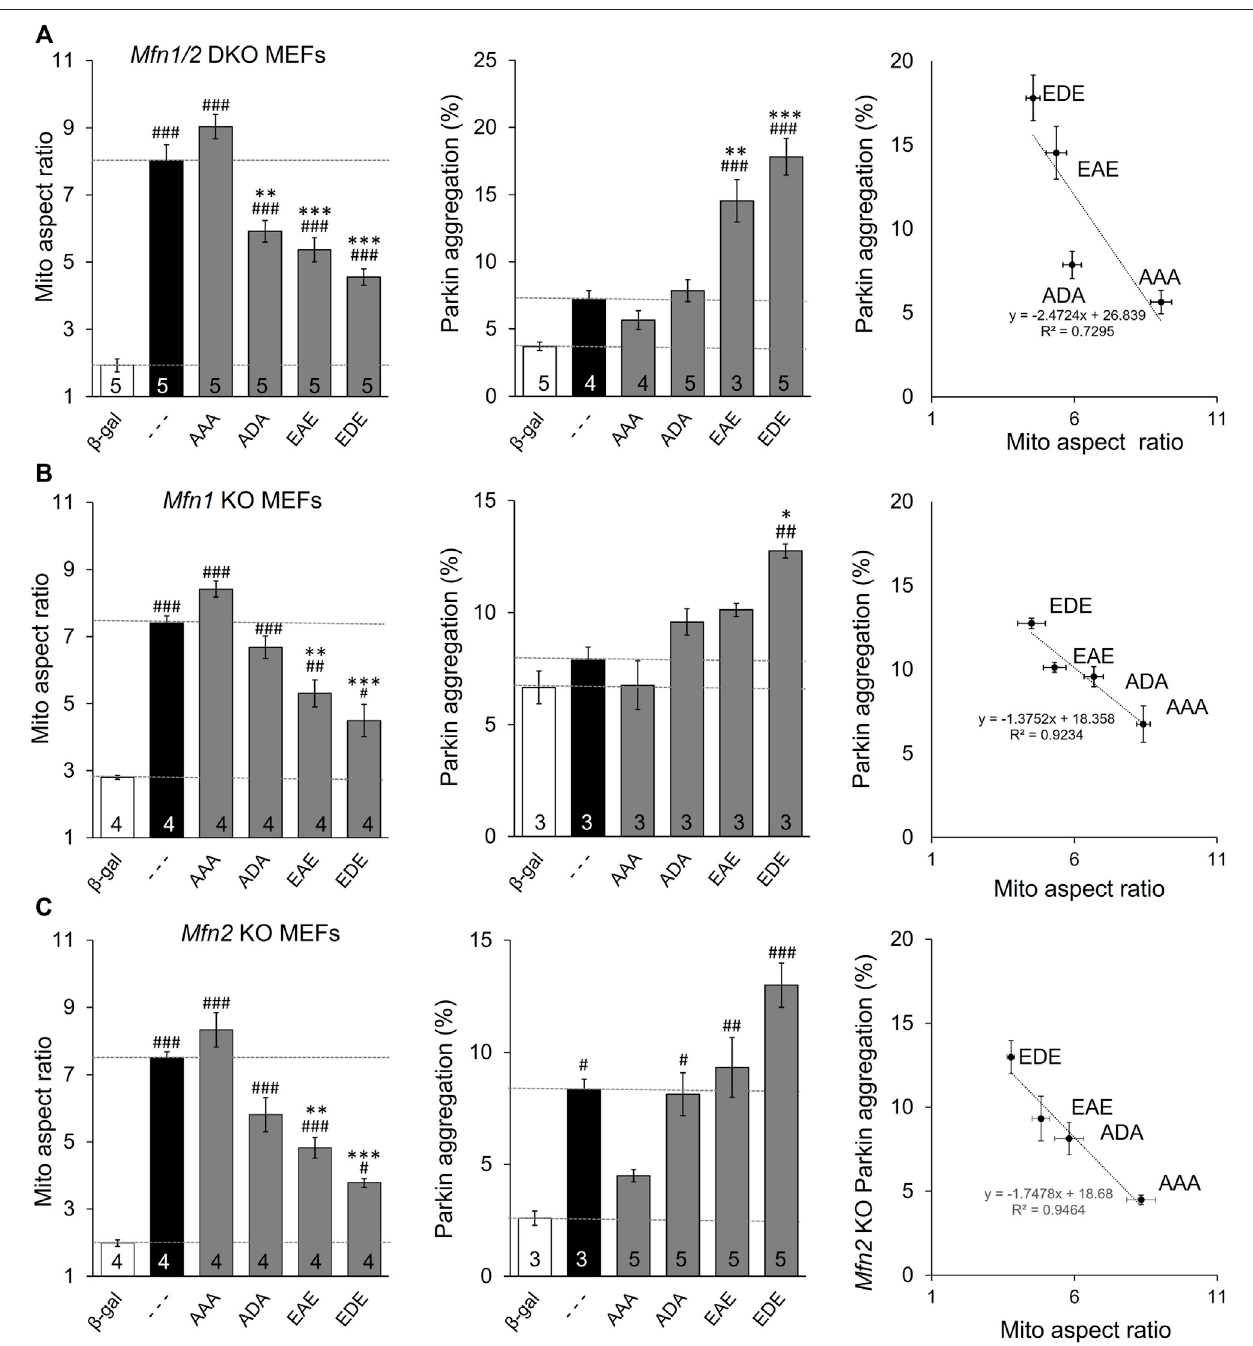
FIGURE 3 | MFN2 PINK1 phosphorylation site mutants dominantly affect mitochondrial fusion and mitophagy in Mfn1 , MFn2 , or Mfn1/Mfn2 null MEFs. MFN2 triple mutants designated as in Figure 1A were expressed by adenoviral transduction of Mfn1 , Mfn2 , or Mfn1/Mfn2 null murine fi broblasts. Adeno β -gal was negative control; --- indicates no mutation at T111, S378 or S442 (i.e. WT MFN2). (A) Mitochondrial aspect ratio (left panel), Parkin recruitment (middle panel) and 2-dimensional plot of mitochondrial aspect ratio vs. Parkin aggregation as a function of MFN2 phosphorylation site (right panel) in Mfn1/Mfn2 null MEFs. (B) Mitochondrial aspect ratio (left panel), Parkin recruitment (middle panel) and a 2-dimensional plot of mitochondrial aspect ratio vs. Parkin aggregation as a function of MFN2 phosphorylation site (right panel) in Mfn1 null MEFs. (C) Mitochondrial aspect ratio (left panel), Parkin recruitment (middle panel) and a 2-dimensional plot of mitochondrial aspect ratio vs. Parkin aggregation as a function of MFN2 phosphorylation site (right panel) in Mfn2 null MEFs. N shown is number of independent experiments. Mutant vs. adeno WT Mfn2: p < 0.05 *; p < 0.01 **; p < 0.001***; MFN2 vs. adeno β -gal: p < 0.05 #; p < 0.01 ##; p < 0.001 ###, all by ANOVA. Error bars are